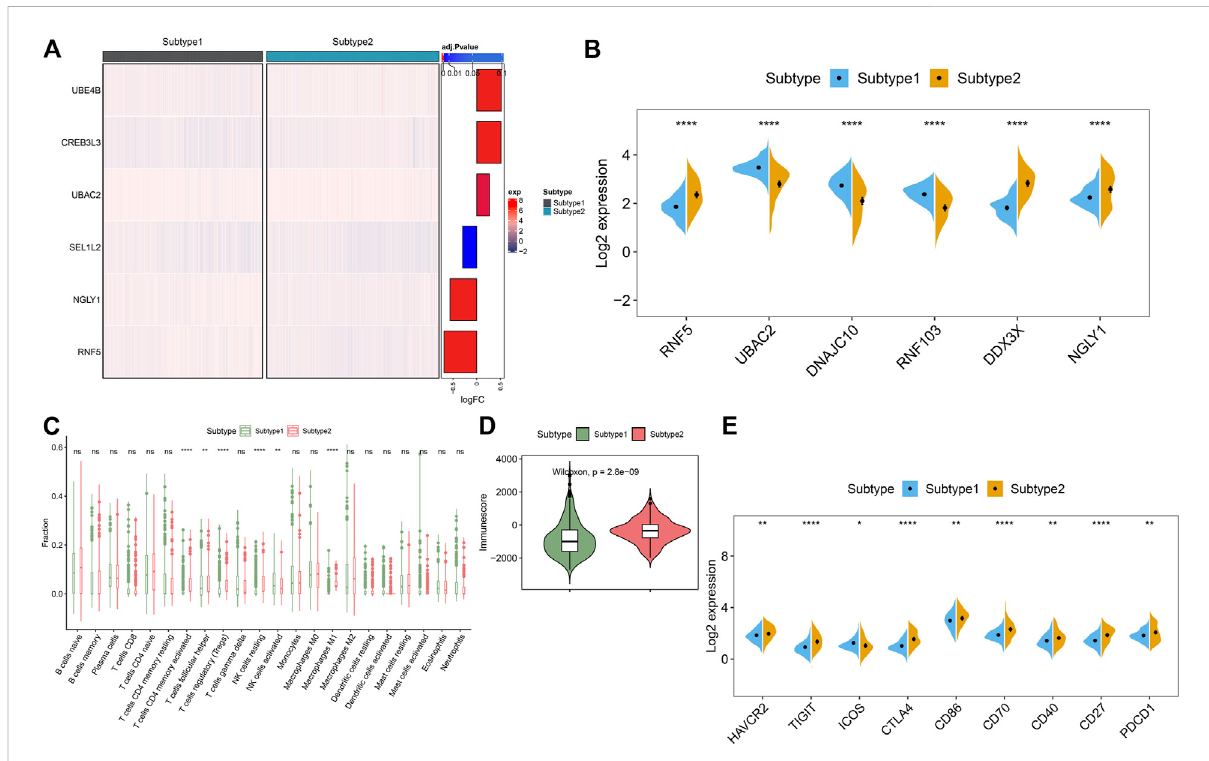
FIGURE 10 Identi fi cation of the differentiation of feature genes and immune characteristics between ER stress subtypes. (A) Representative heatmap reveals the differential expression of six characteristic genes between ER stress subtypes. (B) Representative boxplots show the expression of six characteristic genes between ER stress subtypes. **** p < 0.0001. (C) Representative boxplots show the differences of in fi ltrated immune cells between ER stress subtypes. ** p < 0.01, **** p < 0.0001, ns, no signi fi cance. (D) Representative boxplot reveals the immune score between ER stress subtypes. (E) Representative boxplots present the expression of immune checkpoints-related genes. * p < 0.05. ** p < 0.01.**** p <